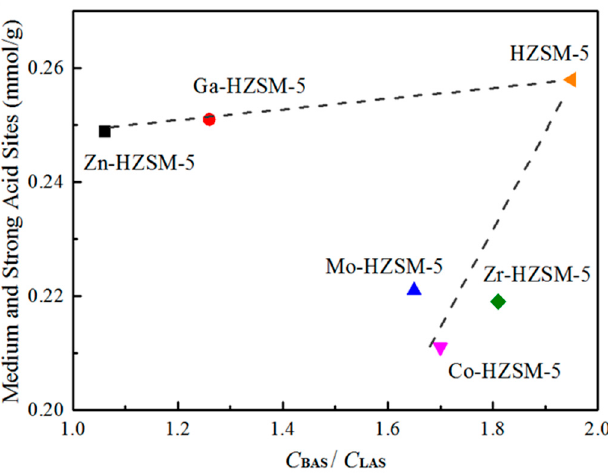
Figure 5. The influence of mental modification on acidity of catalysts.